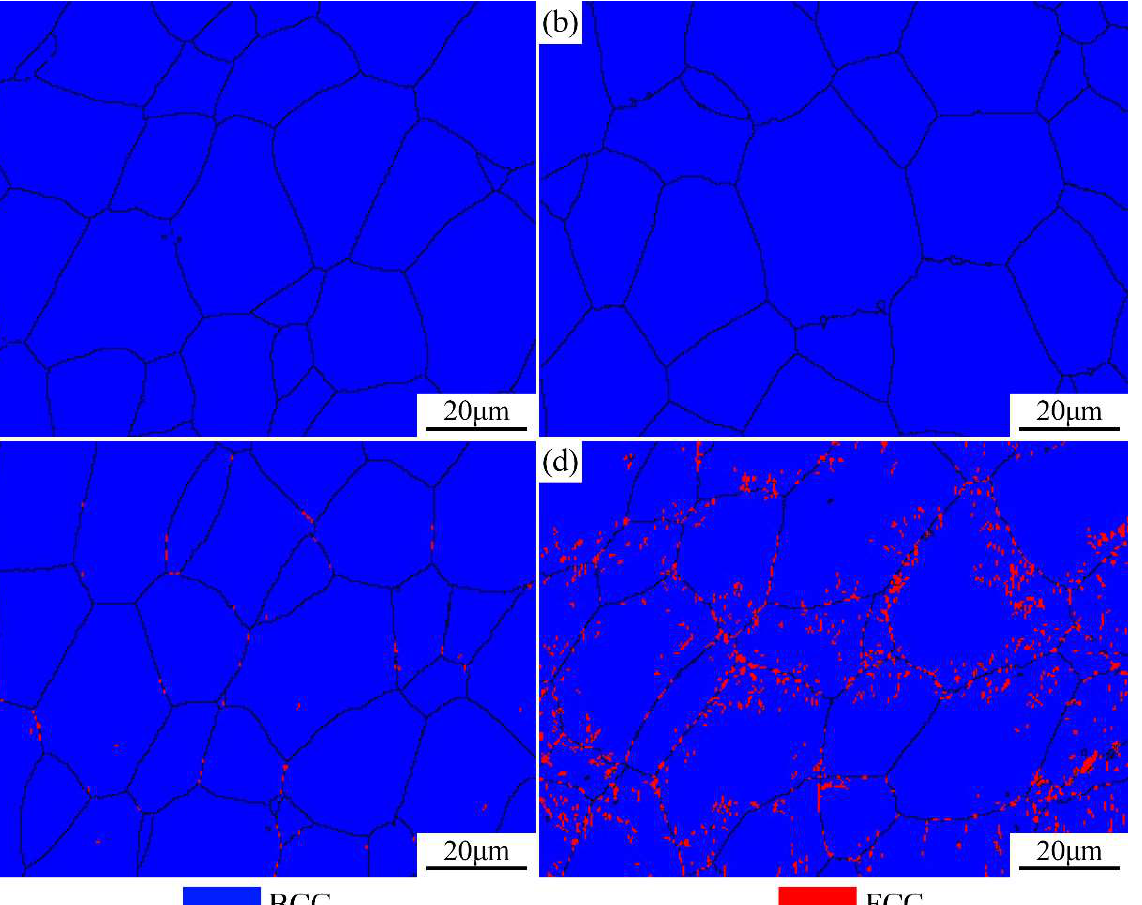
Figure 4. TEM analysis results of the AlCoCrFeNi components after 800 °C high-temperature treat- ment: ( a ) high-magnification electron images; ( b ) selected area diffraction patterns; ( c ) distribution of alloying elements. The content of the FCC phase in the component heat-treated at 1000 °C increased significantly to about 12.7%, as shown in Figure 3d. In addition to being distributed at the grain boundaries, the FCC phase also precipitated inside the grains.